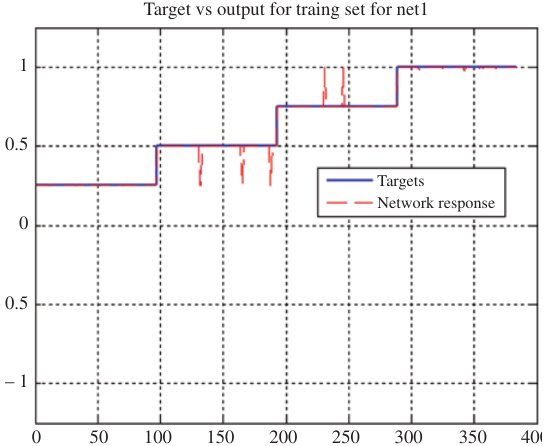
Figure 10: Target vs. Output for Training Data Set for